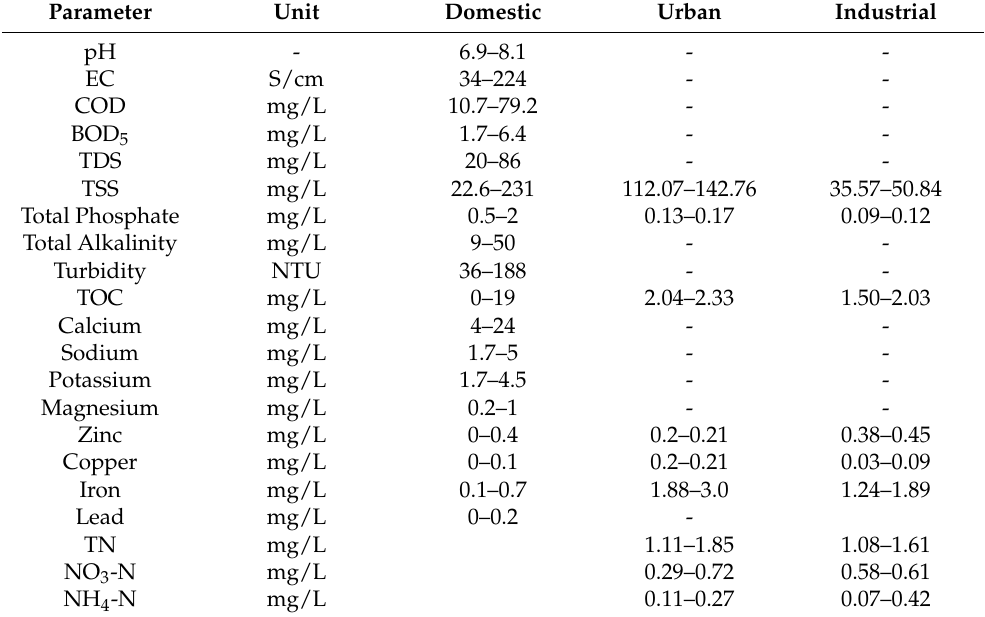
Table 4. Characteristics of stormwater